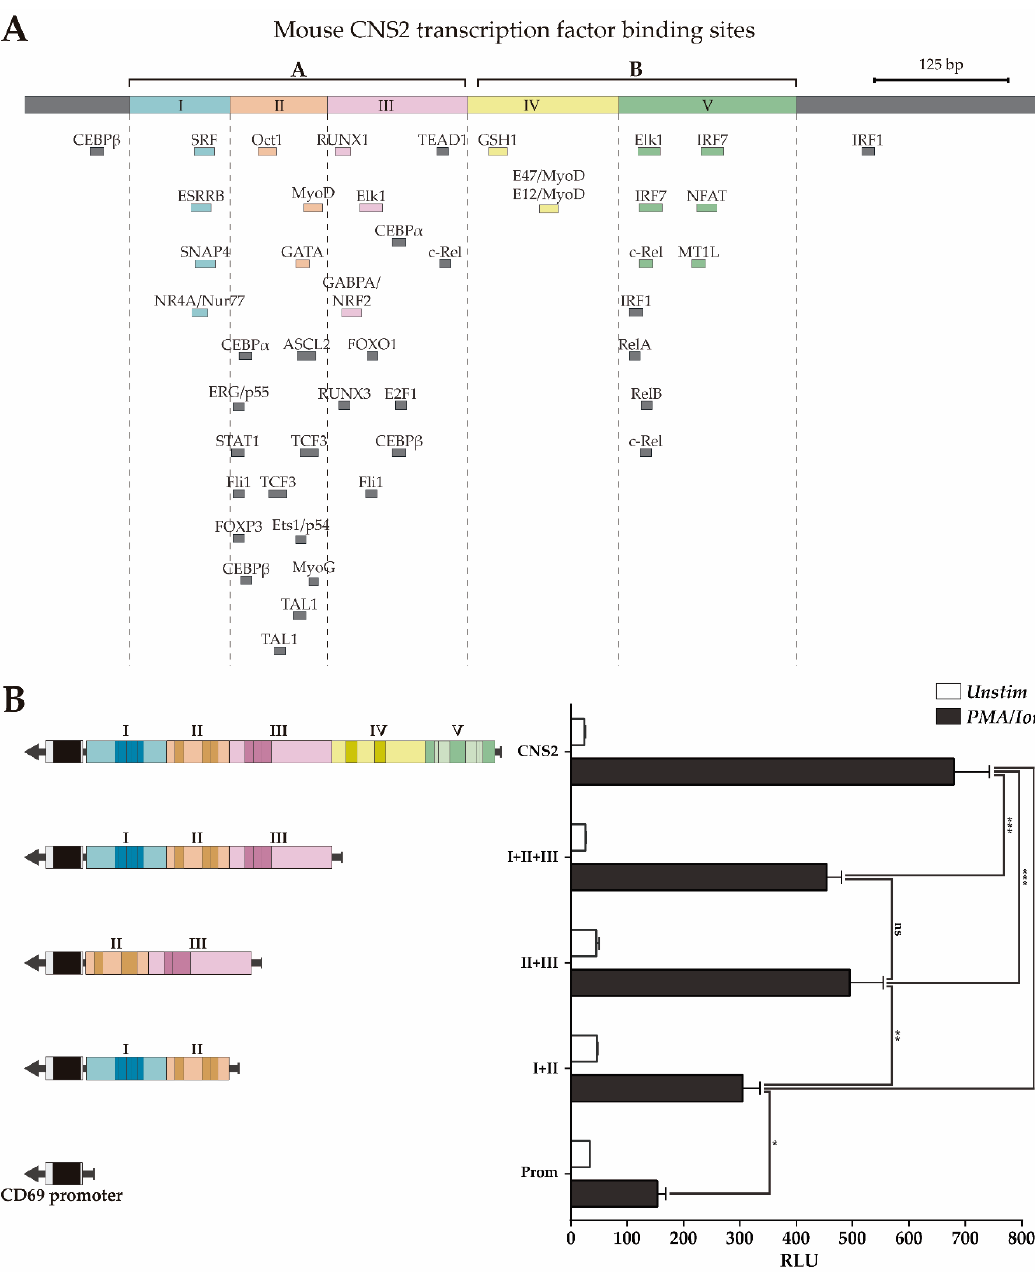
Figure 3. Luciferase activity of CNS2 regions II + III is similar to that of the whole CNS2 sequence. ( A ) Map of the CNS2 regions and TFBS defined by ChIPSeq data. Color boxes indicate transcription factor binding sites conserved among six mammals species, as previously described [34]; grey boxes indicate non-conserved TFBSs identified by public ChIP-seq experiment databases. ( B ) Jurkat cells were transfected with luciferase constructs carrying the mouse CD69 promoter alone or together with the whole CNS2 or regions I + II, II + III or I-III. The bars show the mean RLU of three independent experiments. The error bars show the standard deviation. One-way ANOVA was applied; * ( p < 0.05), ** ( p < 0.01), and *** ( p < 0.001). RLU: Relative luciferase